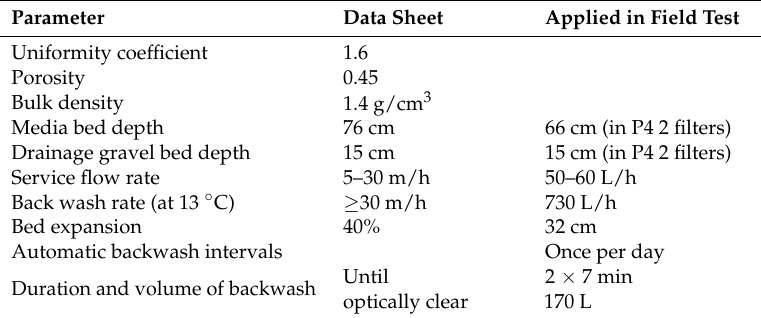
Table 3. Manufacturer and operational data of the GSP Filter.